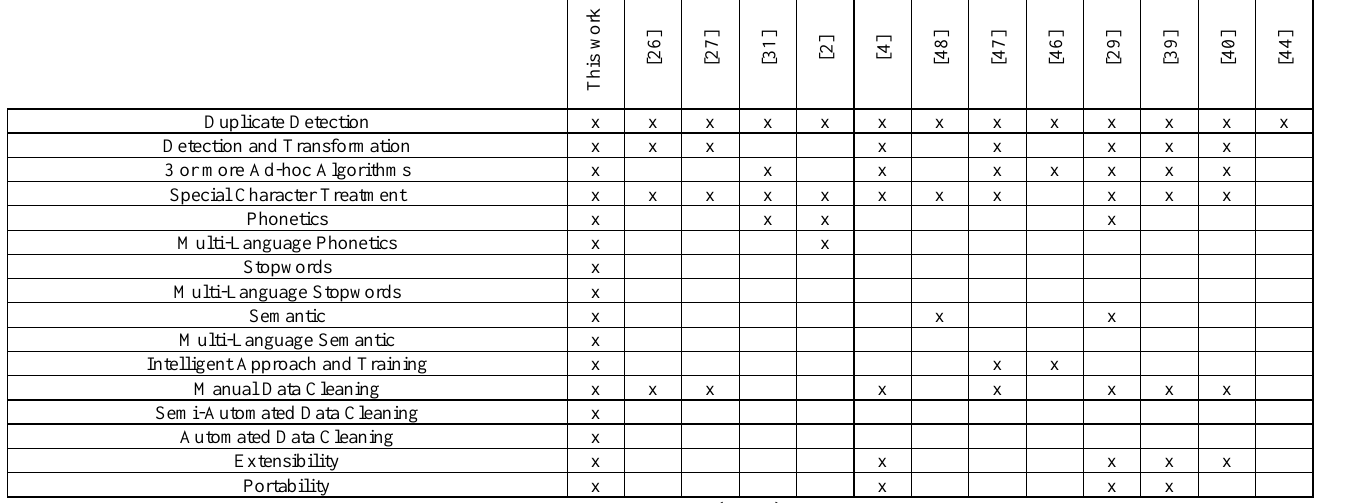
Table 1: Comparison of features contemplated by diverse data cleaning